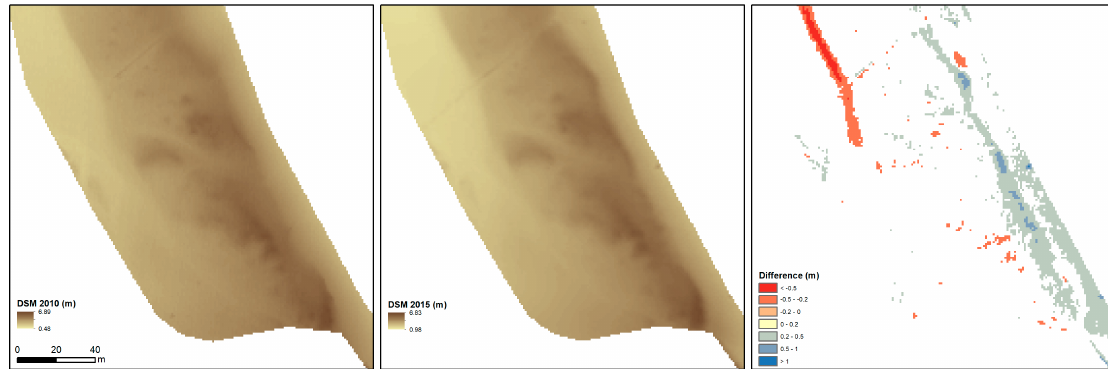
Figure 5. GCD analysis example in a small Rodas sector. From left to right: Digital surface model (DSM) from 2010, DSM from 2015, and difference of digital elevation models (DEM) (DoD) between the two dates.